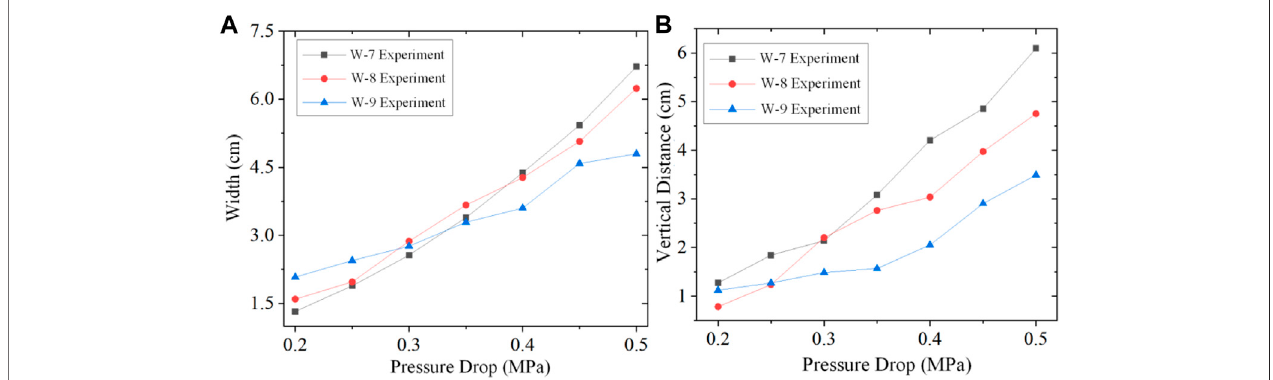
FIGURE11| Periodicpicturesoftheself-oscillation injectorwhen (A) thegaseouscoresizeis7 mm,thegaseous fl owrateis250 L/min,timeintervalsareabout9/ 2078 s, and the shutter time is 20 μ s; (B) the gaseous core size is 6 mm, the gaseous fl ow rate is 184 L/min, time intervals are about 1/400 s, and the shutter time is 20 μ s; and (C) the gaseous core size is 5 mm, the gaseous fl ow rate is 127 L/min, time intervals are about 1/400 s, and the shutter time is 20 μ s.